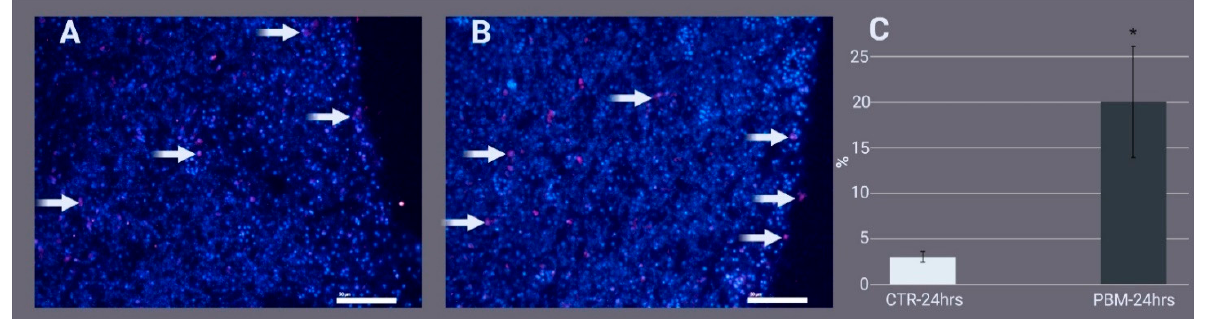
Figure 3. Histological sections showing the regenerating edges of Chondrosia reniformis fragments 24 h after being cut. Immunofluorescence of the ( A ) control (810 nm-0 W photo-biomodulation [PBM]) and ( B ) irradiated (810 nm-1 W PBM) fragments stained for Msi-1 (red) and DAPI (blue). Archaeocytes are scattered in the sponge tissue (arrows). The scale bars are 50 µm. ( C ) Semiquantitative Msi-1 immunofluorescence analysis: the percentage of red fluorescence pixels on total tissue-occupied pixels. Student’s t -test, p < 0.001 (*). CTR = control. Each bar represents the mean ± standard deviation of three independent experiments performed in triplicate. The negative control is shown in Figure